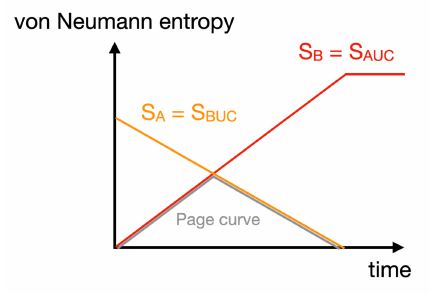
Figure 8 . Regions A and B are interpreted as black hole and radiations, respectively. Region C describes D-branes sitting at the origin, which is inside the horizon. After the Page time, it is natural to interpret that C is a part of